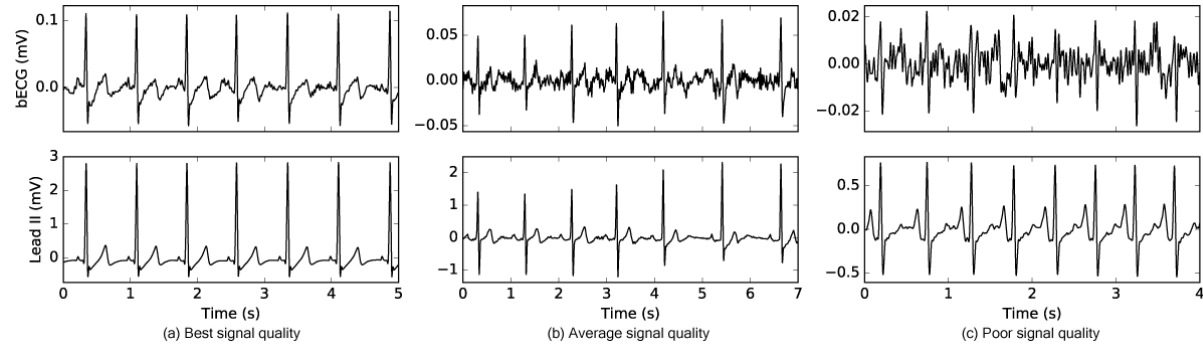
Figure 6. The signal quality of the bECG can vary across subjects and measurements because it is captured using active, dry electrodes. Three examples of signal quality are shown for the bECG (top) compared with a time synchronized Lead II ECG (bottom). The best signal quality example (a) shows the best signal quality achieved from the bECG study. The average example quality (b) shows the typical signal quality of the bECG. The poor example (c) shows a very noisy waveform that passed the signal quality check before analysis. bECG: buttocks electrocardiogram; ECG: electrocardiogram.